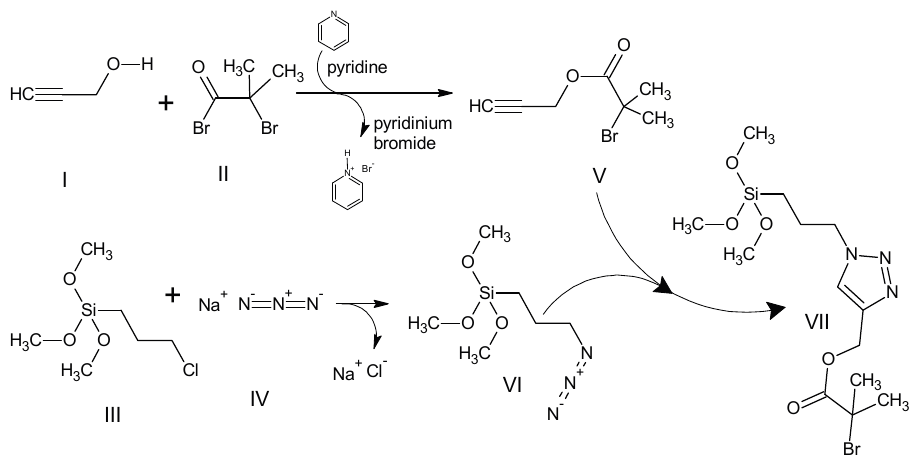
Scheme 1. Synthetic route to ATRP initiator silane coupling agent by “click” chemistry.